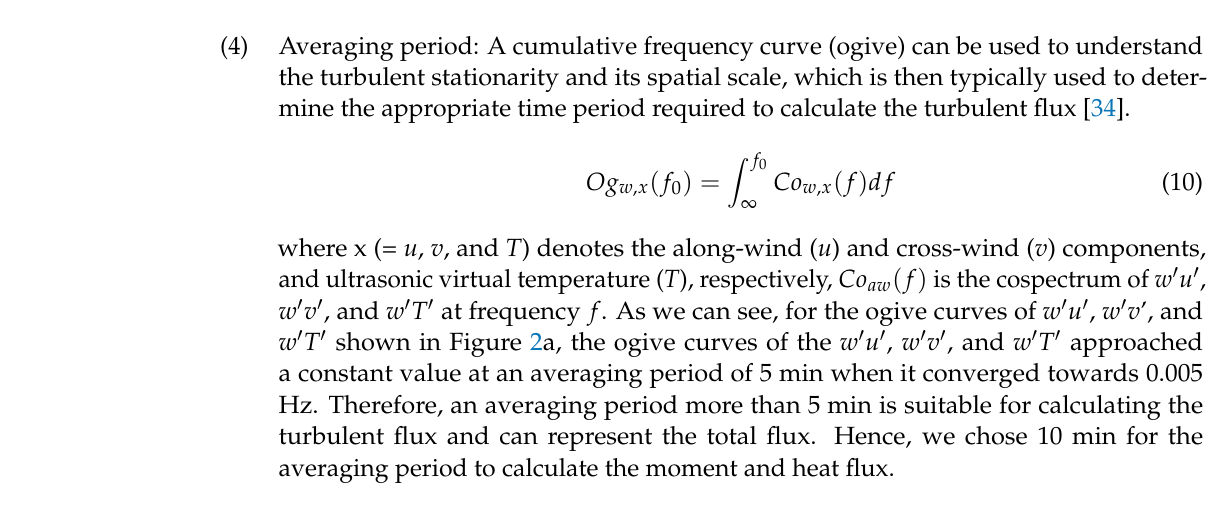
Averaging period: A cumulative frequency curve (ogive) can be used to understand